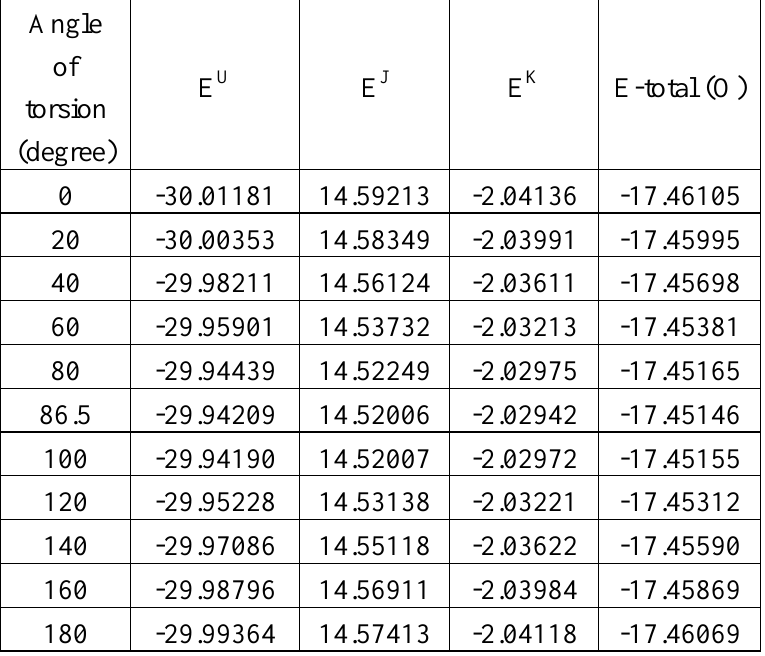
Table 13. The One-center energy and its physical components (a.u) of ‘O’ atom in F